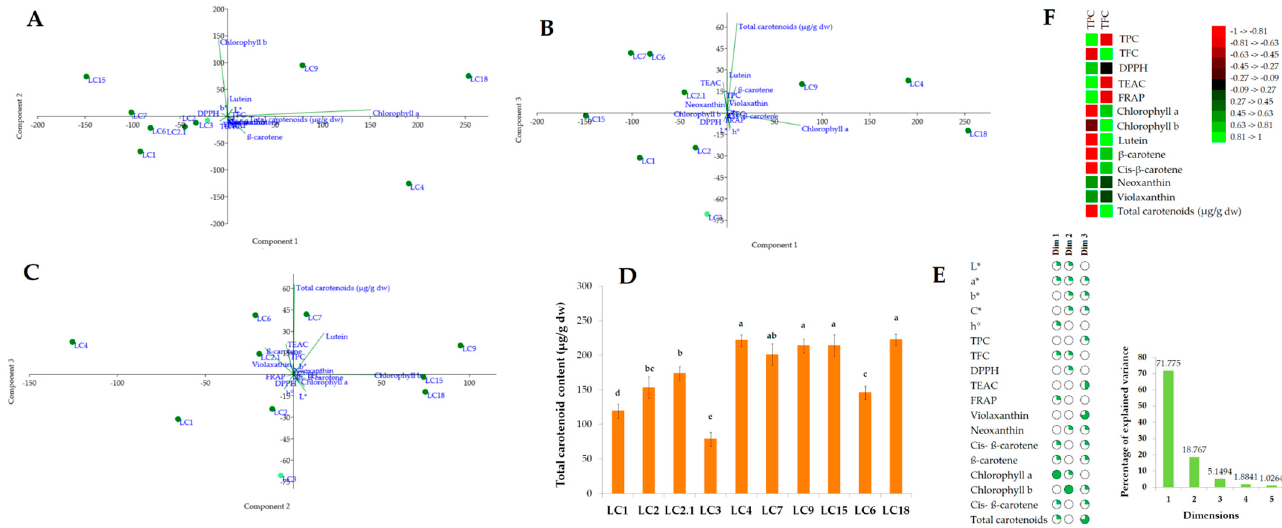
Figure 6. Exploratory multivariate analysis using PCA ( A − C ) with samples distribution into PC1 and PC2, PC1 and PC3, and PC2 and PC3, respectively; ( D ) Total carotenoids content of Cyclamen genotypes leaves; ( E ) Explained variance by each component and contribution of color measurements, antioxidant activities, and carotenoid profiles to the principal components; ( F ) Pearson’s correlation between total phenolic and flavonoid content, antioxidant activities, and carotenoid profiles. the data variance (Figure 7). PC1 and 2 (83.24% of data variance) distinguished the flower samples based on their total anthocyanins, increased malvidin 3- O -glucoside, and